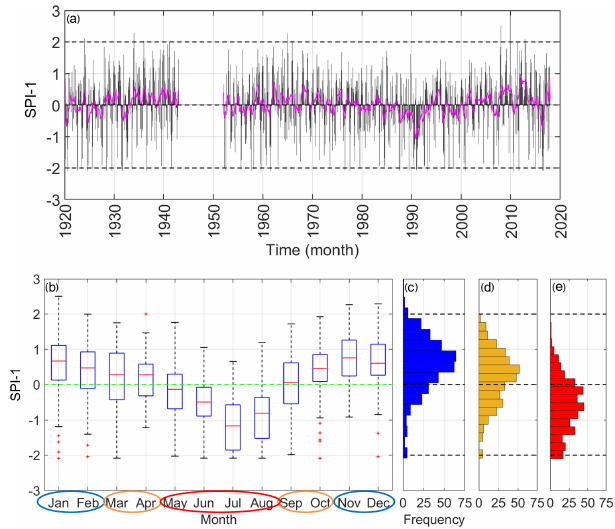
Figure 6. (a) Temporal evolution of SPI-1 values (gray bars) and their 12-month moving average (magenta line) spanning from 1920 to 2018 in the static approach. (b) Box plots of SPI-1 values and the frequency distribution in the (c) rainy period (blue histograms cor- responding to November–December–January–February), (d) tran- sition period (yellow histograms corresponding to March–April– September–October), and (e) dry period (red histograms corre- sponding to